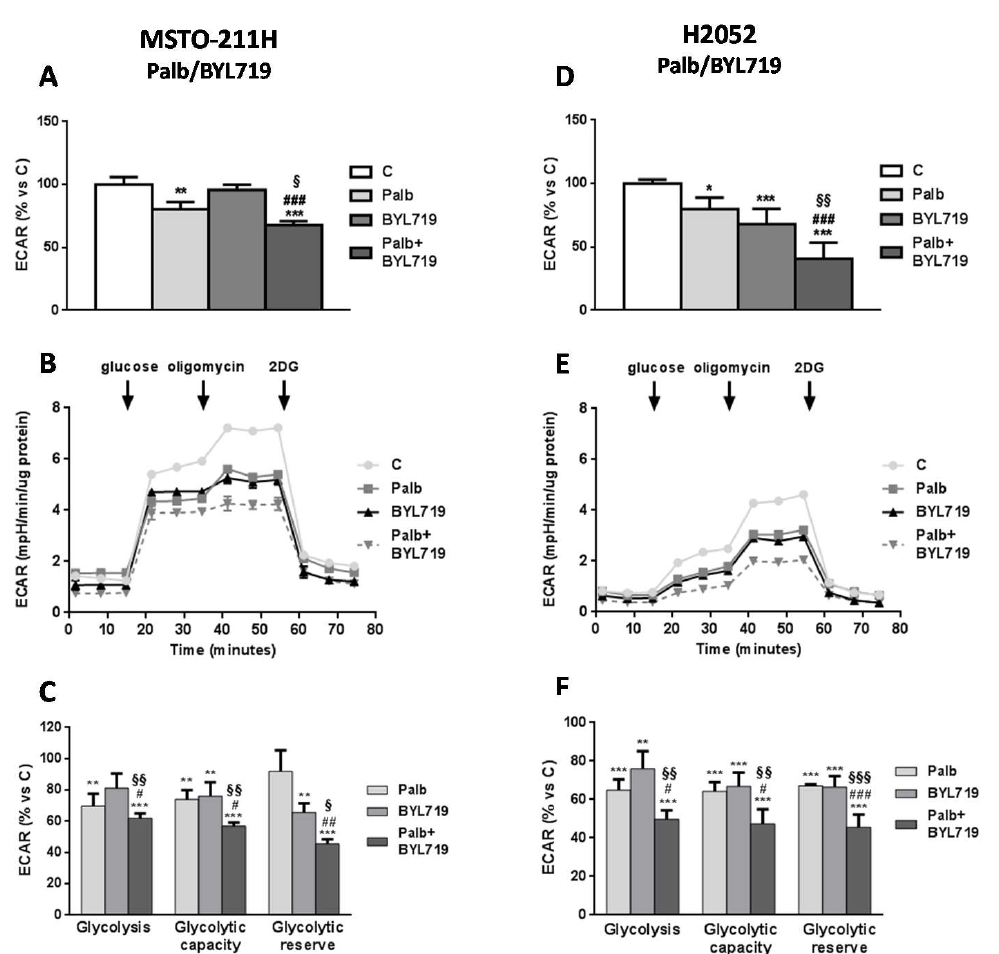
Figure 4. The combined treatment of palbociclib with BYL719 impairs the glycolytic activity of MSTO-211H and H2052 MPM cells. ( A , D ) The glycolytic activity was measured using the Agilent SeaHorse XP analyzer after 24 h of treatment with palbociclib 1 µ M, BYL719 (1 µ M for MSTO-211H cells or 2.5 µ M for H2052 cells) or the combination of palbociclib with BYL719. ECAR data are shown as mpH / min normalized to proteins and represent the mean ± SD of n = 4 independent measurements under normal cell culture conditions. ( B , E ) Glycolytic profiles were obtained using the Agilent SeaHorse Glycolysis Stress Test; the ECAR was measured under glucose starvation and after the sequential addiction of glucose, oligomycin and 2-DG. The ECAR profiles are representative of two di ff erent experiments that yielded similar results. ( C , F ) The parameters of glycolysis, glycolytic capacity, and glycolytic reserve were calculated as percent versus control cells. The data are expressed as the media ± SD of at least three independent measurements. ** p < 0.01, *** p < 0.001 vs. control; # p < 0.05, ## p < 0.01, ### p < 0.001 vs. palbociclib; § p < 0.05, §§ p < 0.01, §§§ p < 0.001 vs.